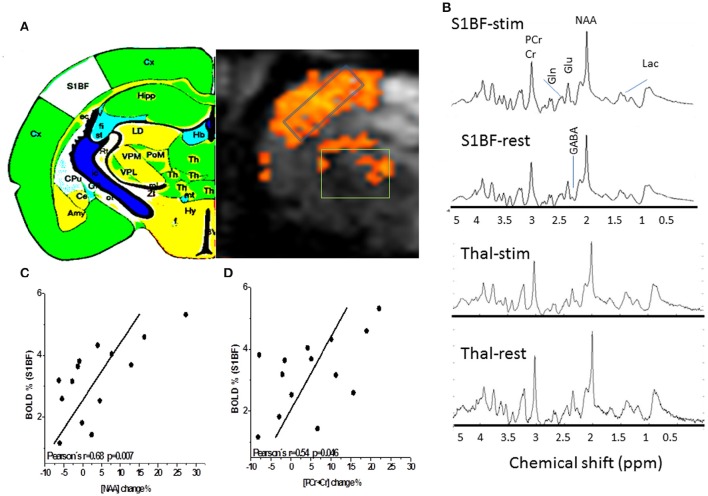
Proton MR Spectroscopy of the rat barrel cortex and the thalamus. (A) BOLD T map overlaid over gradient echo EPI and showing activations both in the barrel cortex and the thalamus. GABA, Glutamate, Glutamine, Glucose, and Lactate levels were measured at rest and during long stimulation periods both in the thalamus (n = 11) and in S1BF (n = 15) in the represented voxels of interest. The thalamic voxel of interest (36 μl) for fMRS in rats is depicted. In order to increase SNR levels for thalamic MRS acquisitions, the thalamic voxel encompassed several thalamic nuclei of interest [VPM, Reticular thalamic nucleus (RTN) and Posteromedian thalamic nucleus (POm)] that can be recognized by reference to the labeled map. Cx, Cortex; Th, Thalamus; S1BF, Primary somatosensory barrel field; Hb, Habenula; Hip, Hippocampus; Cpu, Caudate Putamen; Amy, Amygdala; (B) Examples of labeled spectra (mean spectra averaged over rat population and over time) in both structures acquired during stimulation and rest periods are shown. Increased and decreased levels of Glu and Lac levels during TGN stimulations can be visualized in each structure respectively. (C) and (D) BOLD effects result in a decrease of NAA and tCr (PCr+Cr) peak linewidths (increase in T2*). Changes in linewidths can also be reflected by a change in peak height reported here. Positive correlations (r = 0.68, p = 0.007 and R = 0.54, P = 0.046) were found between BOLD responses in S1BF and percent change of NAA and PCr+Cr peak height respectively. These changes may represent surrogate markers of BOLD responses but remain to be validated.